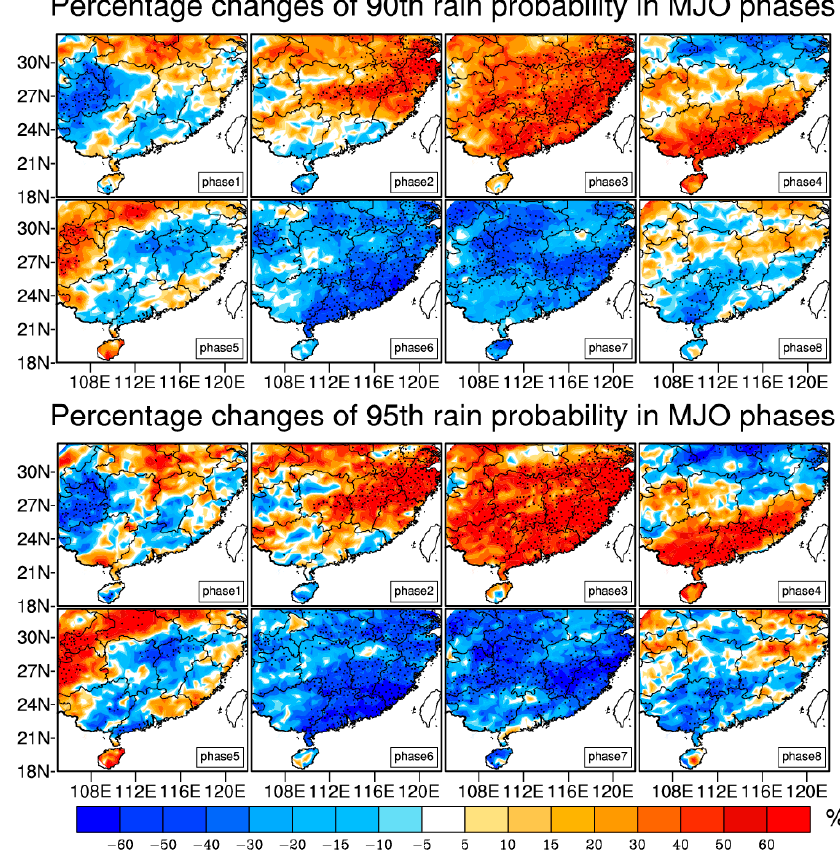
Figure 4. Percentage change in the probability of extreme events at 90th (upper two rows) and 95th (bottom two rows) percentile for each of eight phases of MJO with respect to climatology PDF. The dots represent stations that exceed the 95% confidence level.